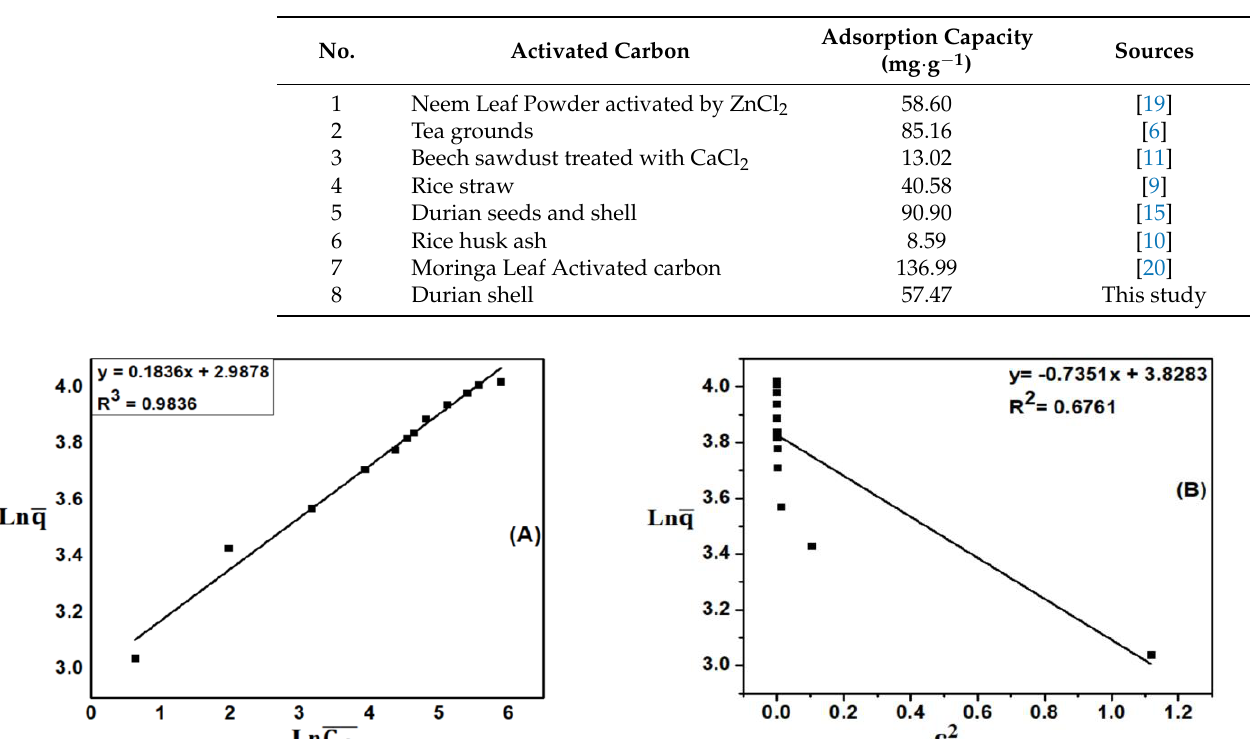
Figure 10. ( A ) The dependence of lnq on lnC cb for MB adsorption and ( B ) The dependence of lnq on ɛ 2 according to Dubinin – Radushkevich isotherm model.